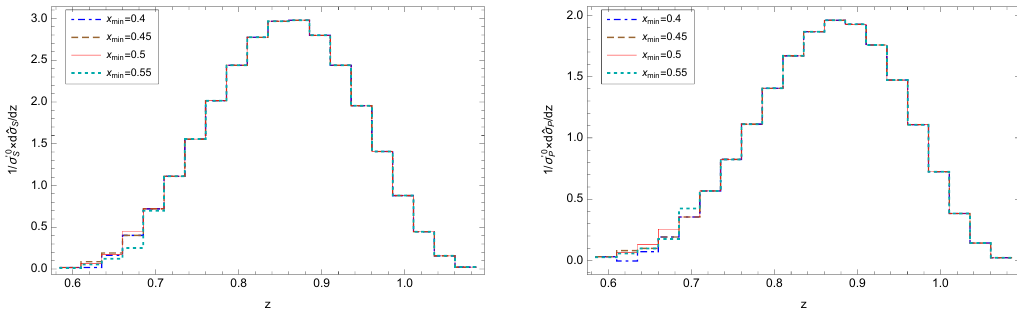
Figure 5 . The differential cross sections in SGF with different x min .